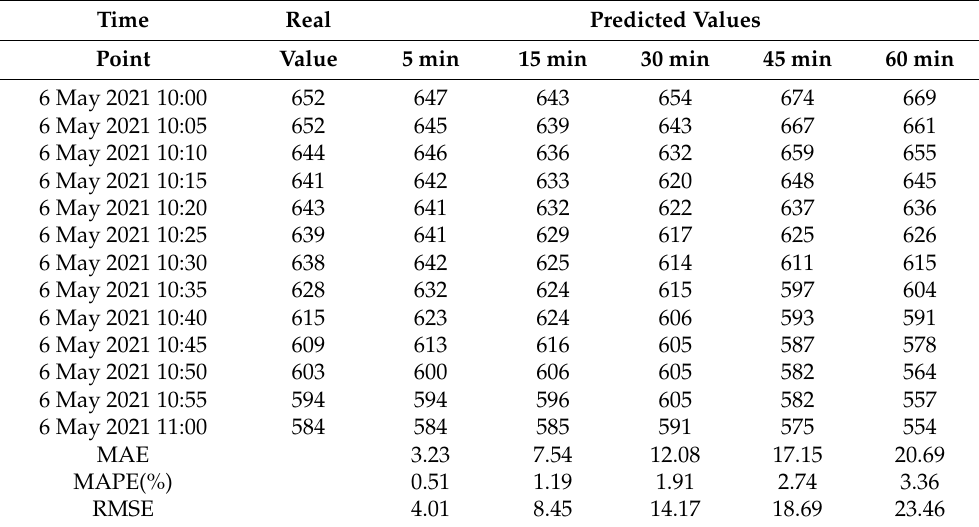
Table 3. Comparisons between the real and predicted numbers of VPSs at the St7 parking